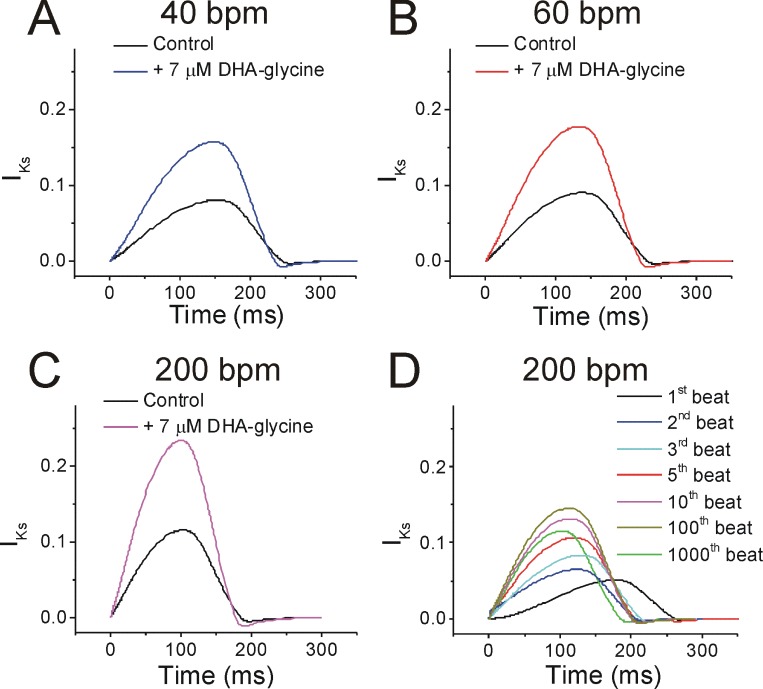
Rate dependence of the IKs current during simulated ventricular action potentials and effects of DHA-glycine.(A) Simulations of the IKs current during the ventricular action potential at 40 bpm in control conditions (black line) and in 7 µM DHA-glycine (dark blue line). (B) Simulations of the IKs current during the ventricular action potential at 60 bpm in control conditions (black) and in 7 µM DHA-glycine (red dashed line). (C) Simulations of the IKs current during the ventricular action potential at 200 bpm in control conditions (black) and in 7 µM DHA-glycine (magenta dashed line). (D) IKs currents during simulation of the ventricular action potential at 200 bpm in control conditions after the indicated number of beats.